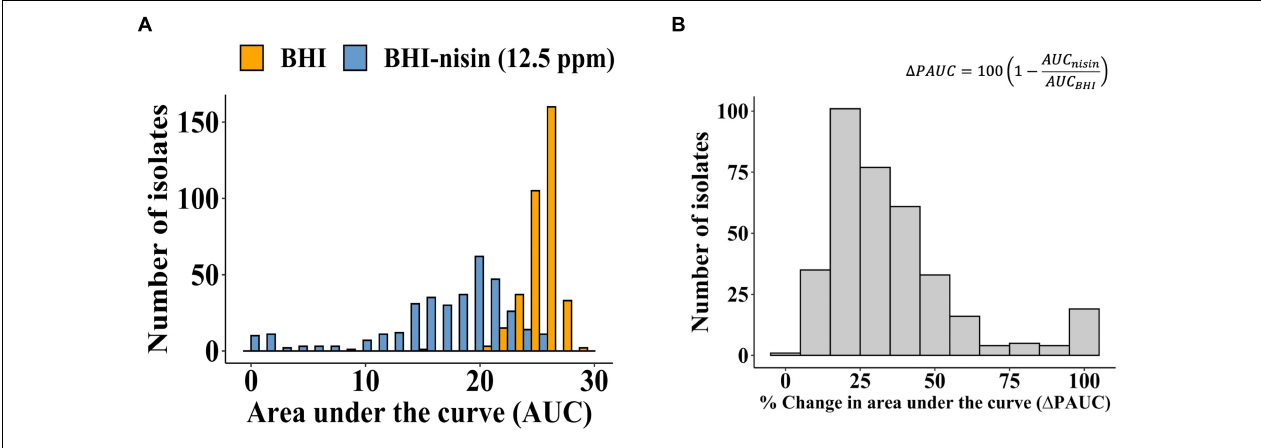
FIGURE 1 | Nisin impact on growth capacity of the 356 L. monocytogenes field strains. (A) Distribution of the growth curve AUCs determined for growth in BHI and BHI-nisin. (B) Overall distribution of the nisin inhibition induced (cid:49) PAUCs for the 356 L. monocytogenes strains displayed left skewing with a mean (cid:49) PAUC of 35.53% indicating high nisin resistance among the examined